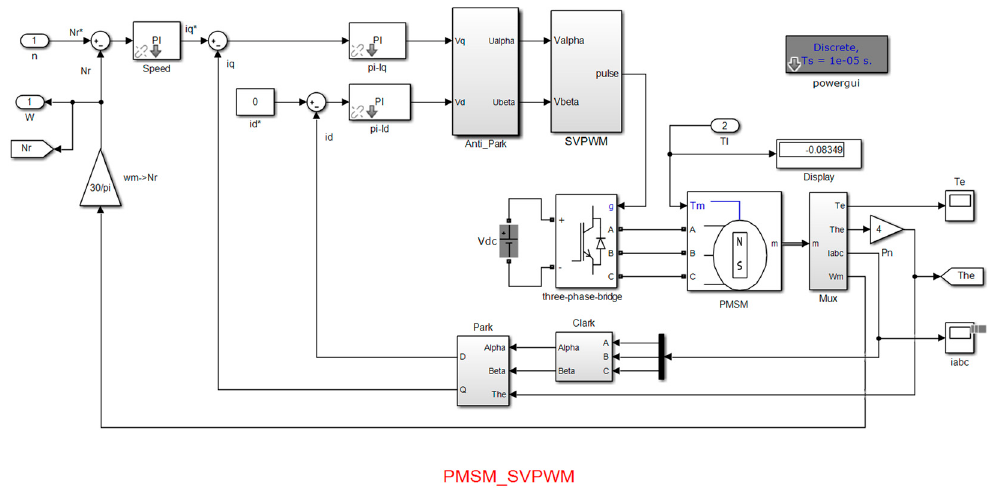
Figure 3. Simulation model of three ‐ phase permanent ‐ magnet synchronous motor (PMSM) vector control.